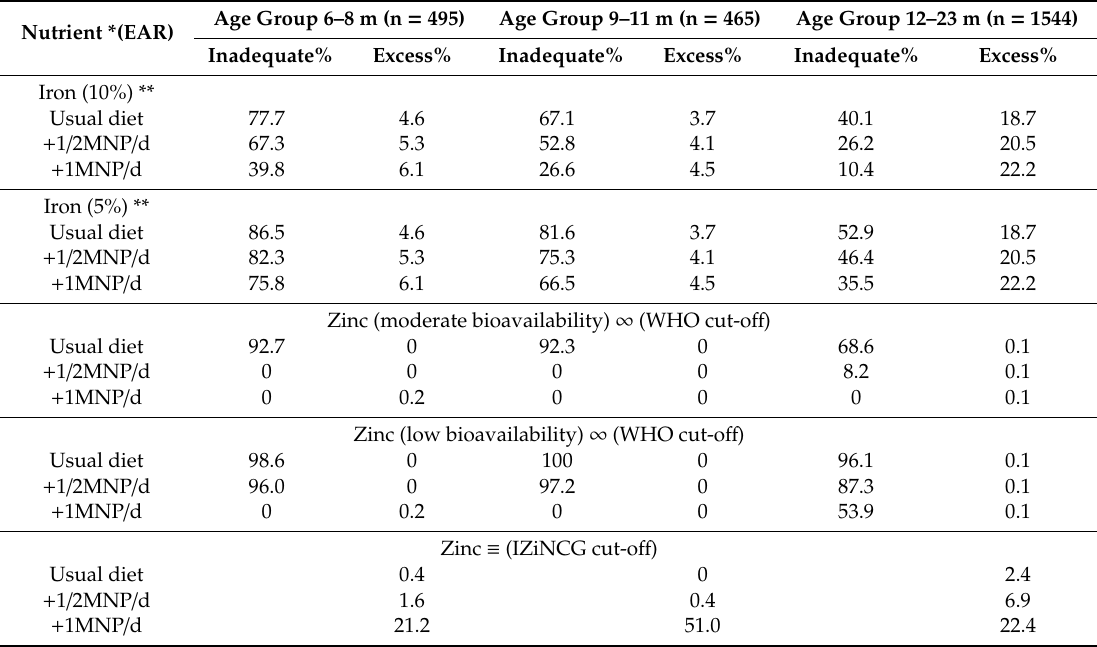
Table 5. Calculated inadequate and excess intake of selected nutrients at usual intake, addition of 1 MNP every other day (3.5 sachets / week) and daily, among Ethiopian children at di ff erent age